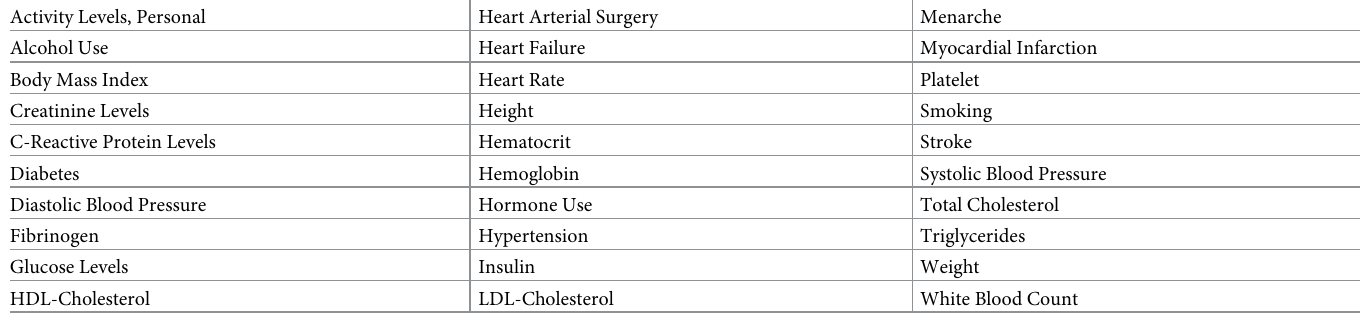
Table 3. Phenotype classes represented in the Population Architecture using Genomics and Epidemiology (PAGE) I study PheWAS in African Americans. Pheno- type-class binning first groups the phenotypes into categories within a PAGE study and then groups those categories across PAGE study sites. Below are the 30 phenotype classes that individually-labeled phenotypes across the studies were